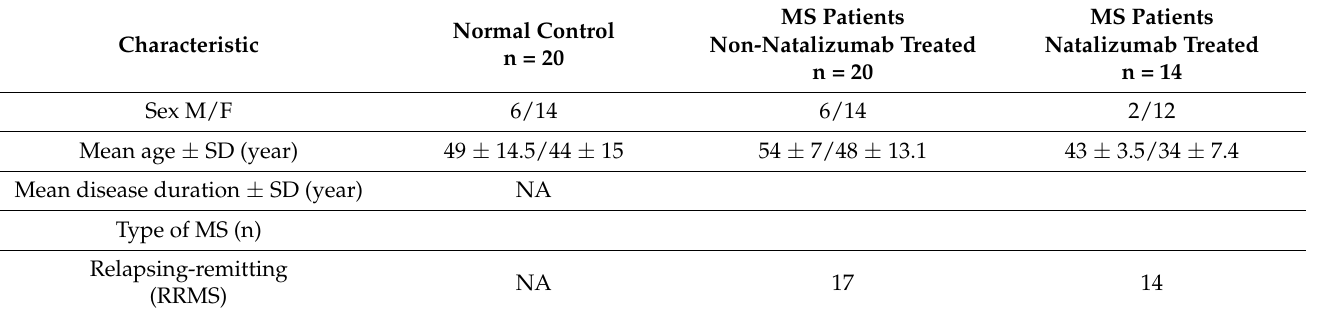
Table 3. Healthy controls and MS patient cohorts’ characteristics.